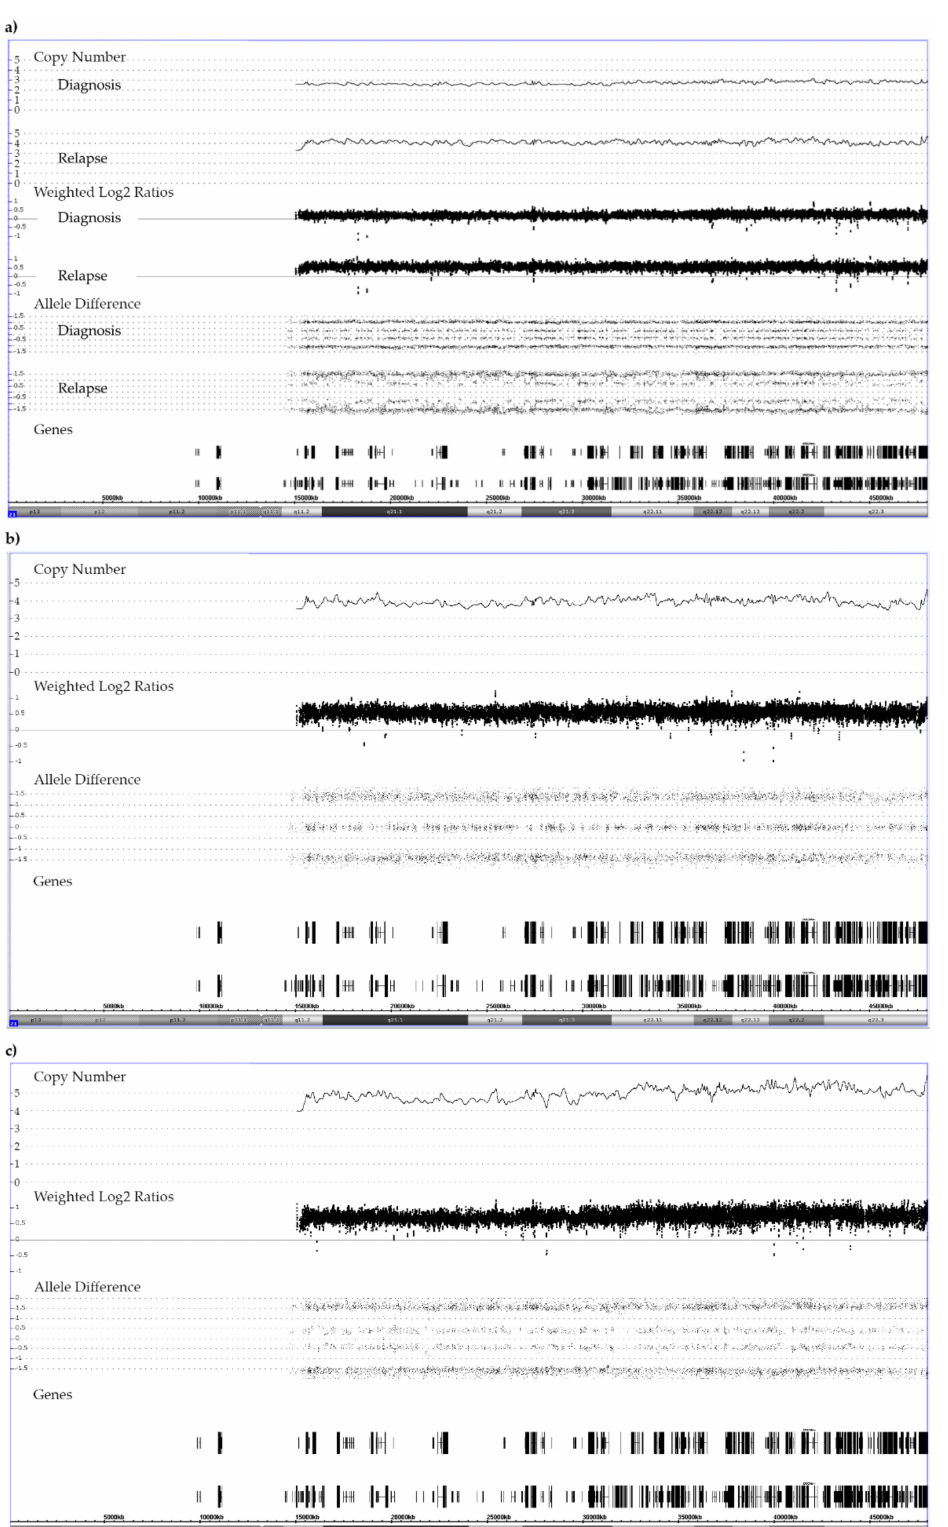
Figure 8. Representative examples of the allele distribution patterns in constitutionally disomic patients with ( a ) a “2 + 1” trisomy at diagnosis and a “3 + 1 tetrasomy” at relapse, ( b ) a “2 + 2” tetrasomy and ( c ) a “3 + 2” pentasomy of chromosome 21. The corresponding RUNX1 FISH-based enumeration of chromosome 21 copies revealed the following clonal distribution: ( a ) at diagnosis 19% with two, 81% with three and at relapse 19% with two, 9% with three, 63% with four and 9% with five copies; ( b ) 7% with two, 13% with three, 80% with four copies; ( c ) 6% with two, 6% with four, 88% with five